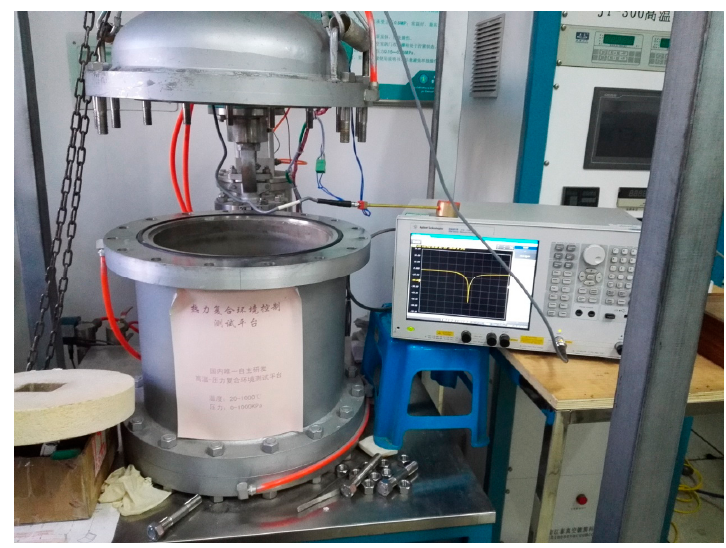
Figure 3. Experimental validation measurement setup.